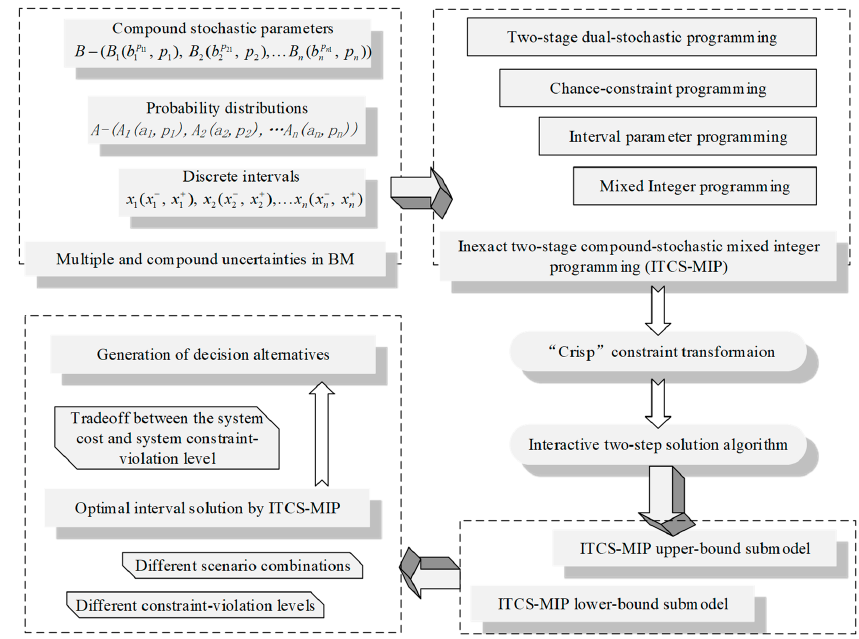
Figure 2. Modelling flowchart for the ITCS-MIP model and its solution